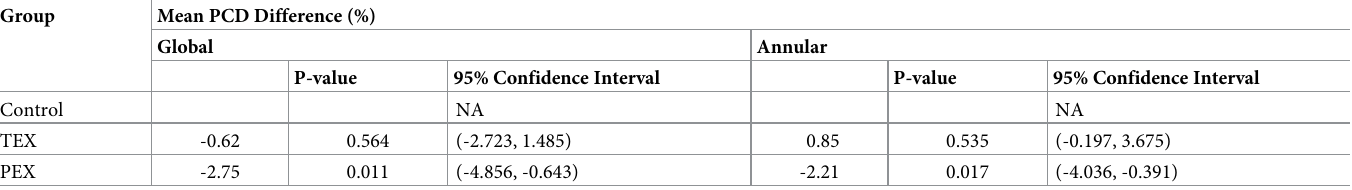
Table 2. Differences in globular, annular PCD among TEX and PEX comparing with control group. Group Mean PCD Difference (%)